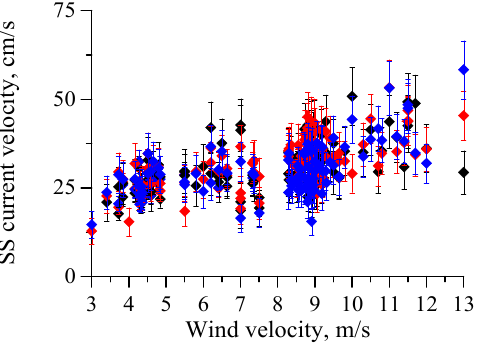
Figure 7. Subsurface current velocities vs. wind speeds (from Figure 4). Black symbols—S-band, red—C-band, blue—X-band.